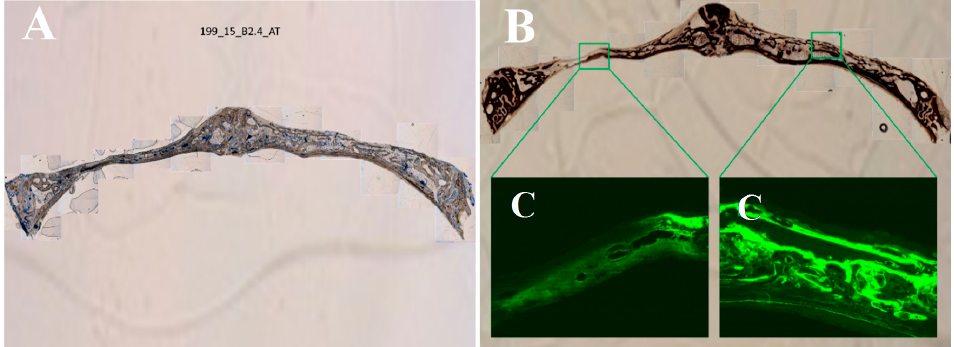
Figure 9. Histology images. ( A ) Toluidine blue; ( B ) Von Kossa and ( C ) Fluorescence. Distance from one side of the bone fragment to the other ≈ 35 mm. Left side is control (PLGA). Table 4. Histomorphometric study (* p ≤